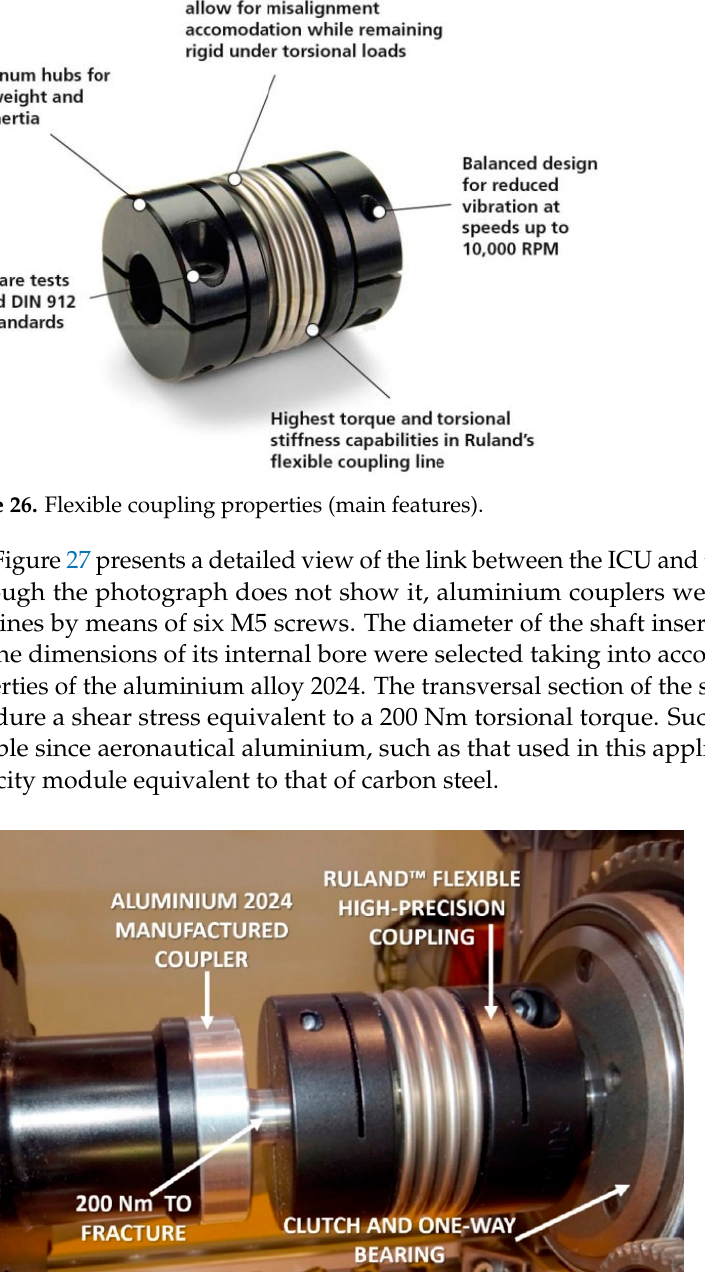
Figure 27. Flexible coupling properties.